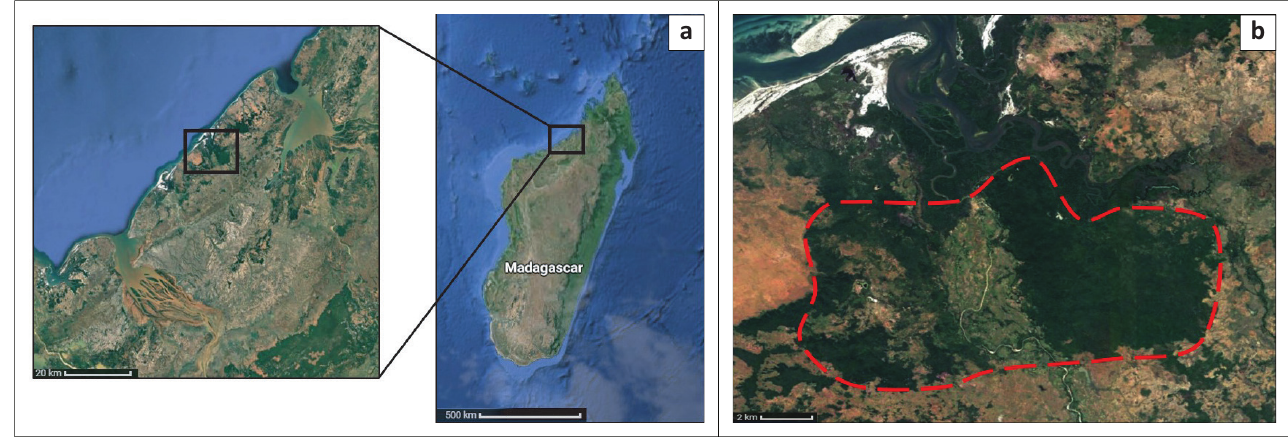
FIGURE 1: Maps showing (a) the location of the Mariarano study area within Madagascar as a whole and within the Mahajanga II district of north‐western Madagascar and (b) satellite image of the Mariarano region, with the boundary of the study area demarked with a dashed red